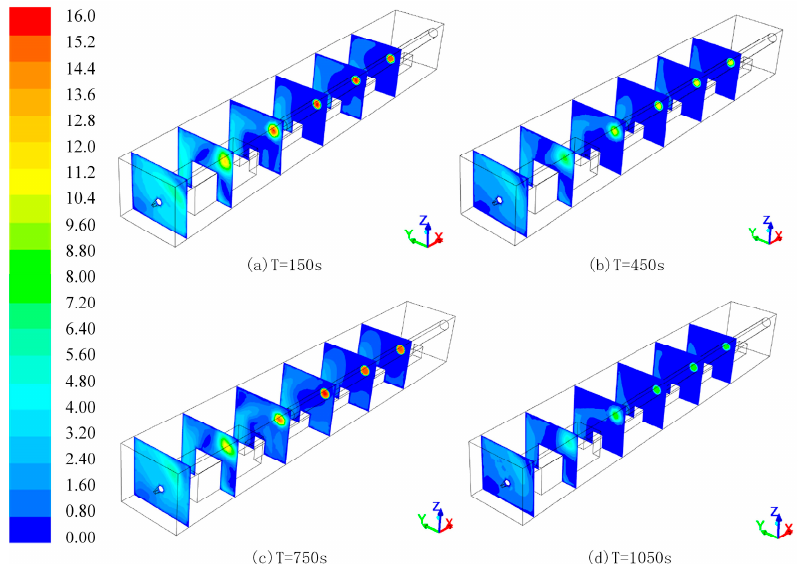
Figure 8. Airflow velocity (m/s) profiles at different cross sections (with a distance of 1 m, 5 m, 10 m, 15 m, 20 m to the driving face).